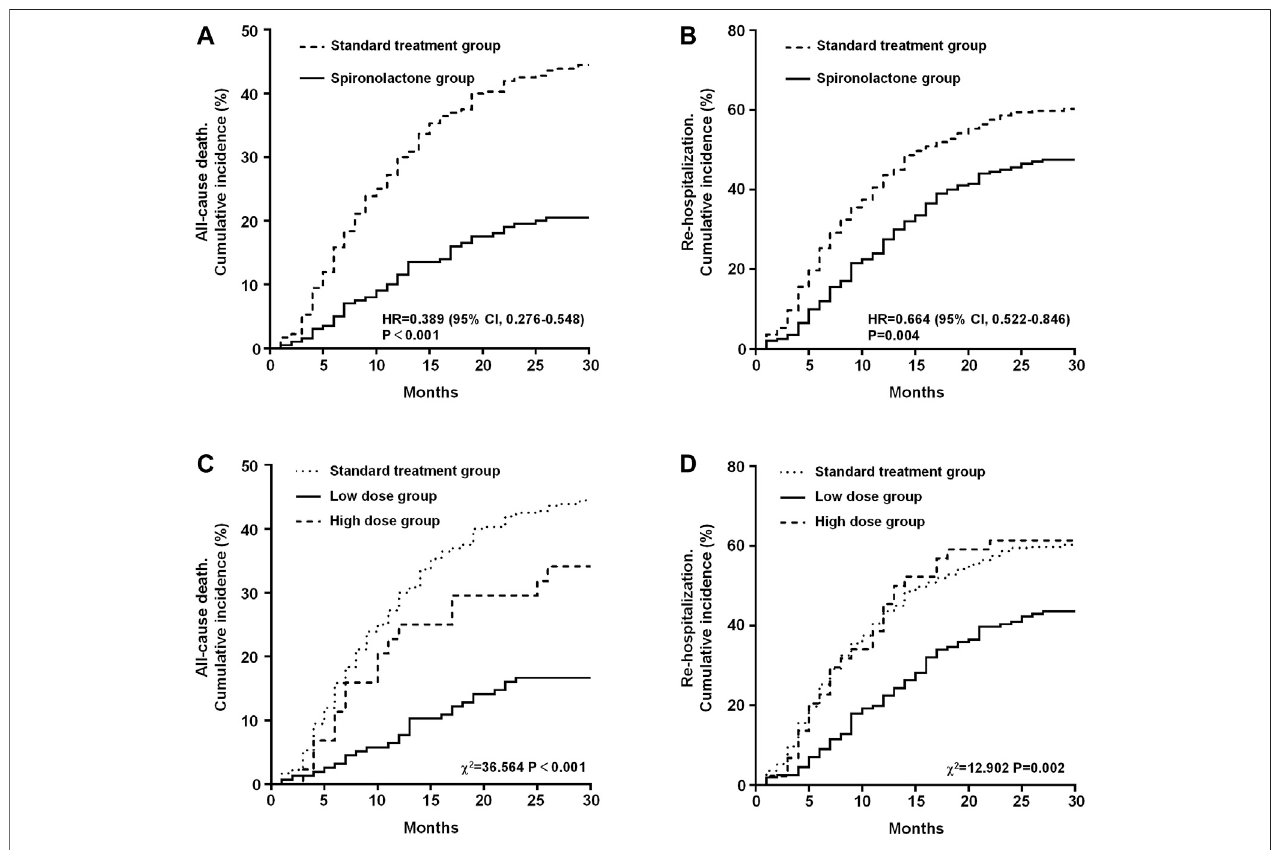
FIGURE 2 | Kaplan-Meier estimates in the standard treatment group and spironolactone group for the rate of all-cause mortality (A) and re-hospitalization (B) . Kaplan-Meier estimates of all-cause mortality (C) and re-hospitalization rates (D) grouped by dose of spironolactone. CI, con fi dence interval; HR, hazard risk.